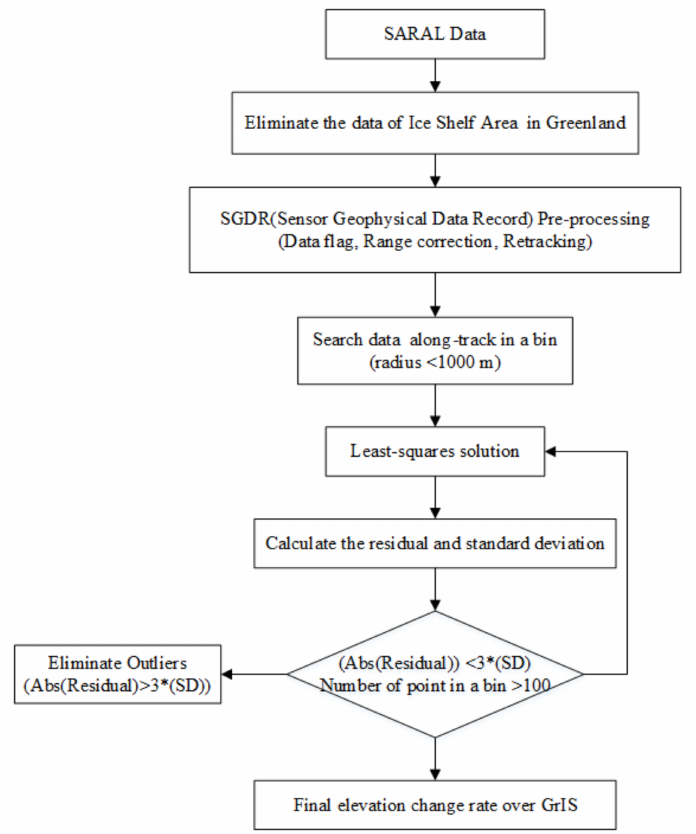
Figure 1. Sketch of the processing scheme to derive elevation change from SARAL over the Greenland ice sheet (GrIS). To constrain each solution, 3 σ , 18 distinct epochs and more than 100 points are needed to estimate the parameters in the least-squares